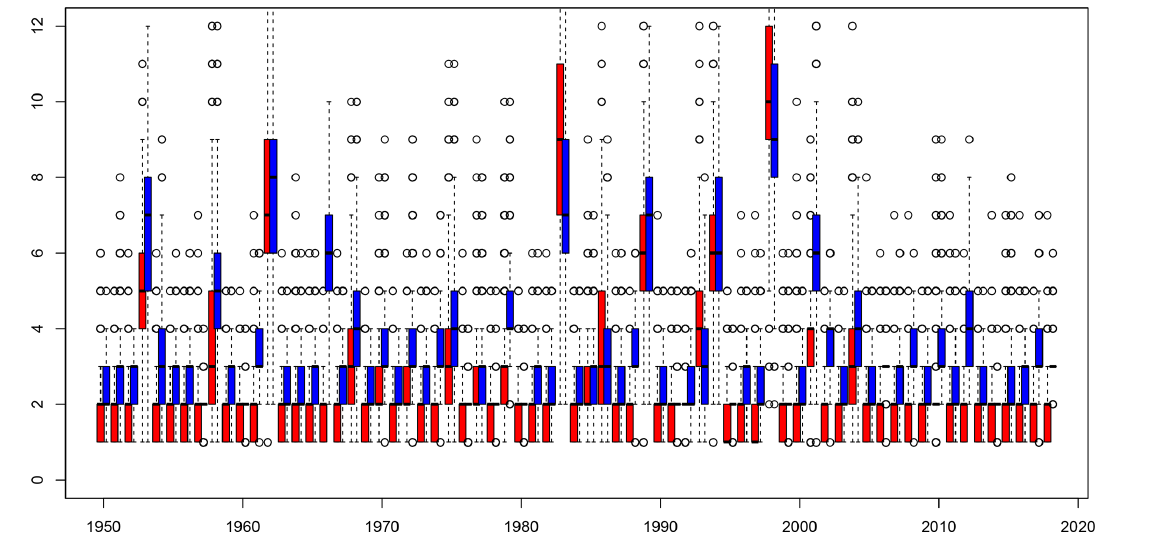
Figure A7. Maximal number of times a single date is repeated for each simulated year. The boxplots indicate the range of this maximal repetition number for the 1000 simulations for simulations of the static (blue) and dynamic (red) stochastic weather generator. The boxes of boxplots indicate the median ( q 50), lower ( q 25), and upper ( q 75) quartiles. The upper whiskers indicate min[max( T ), 1 . 5 × ( q 75 − q 25)]. The lower whisker has a symmetrical formulation. The points are the simulated values that are above or below the defined